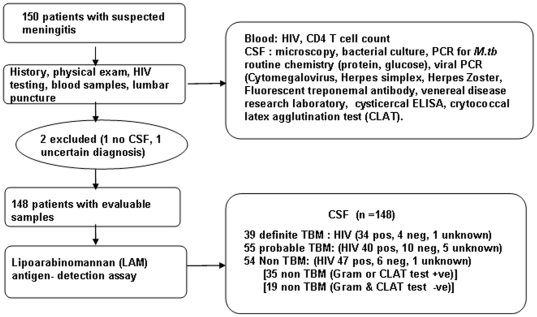
Summary flow chart of patient categorisation and investigations performed at recruitment.